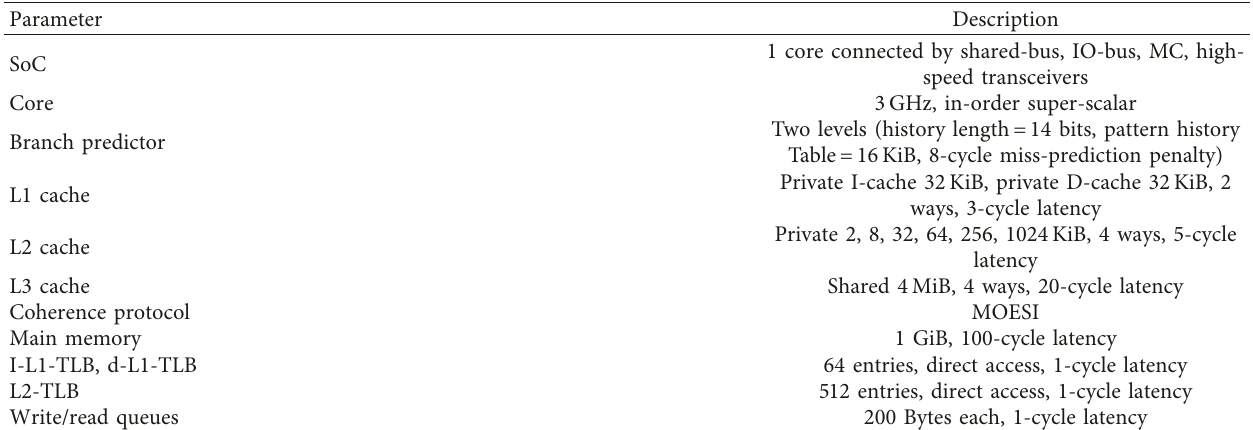
Table 4: COTSon architectural parameter.